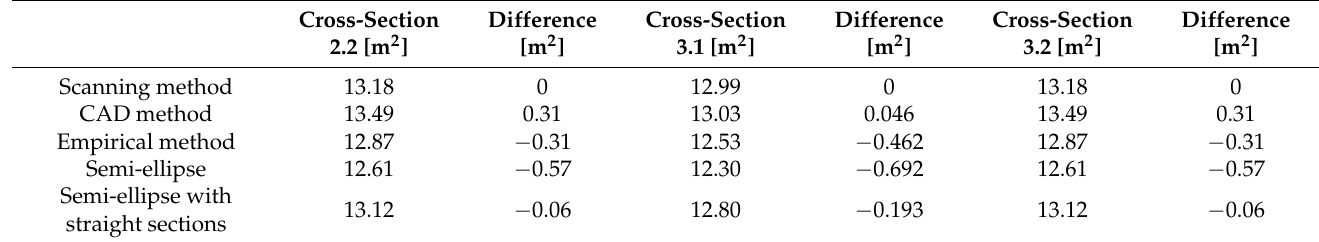
Table 3. Results of cross-sectional area measurements.